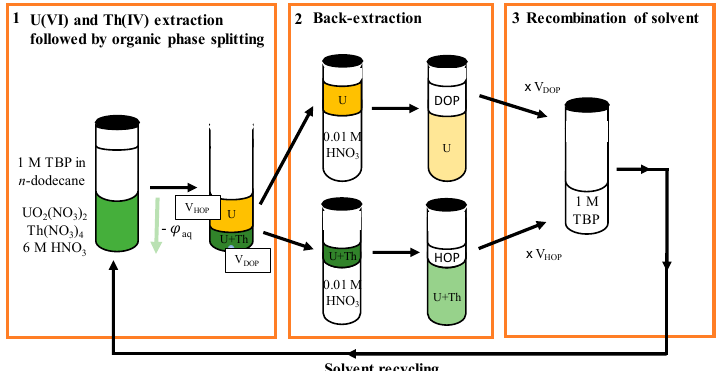
Figure 6. Schematic diagram of complete process, including solvent recycling, based on organic phase splitting induced by temperature